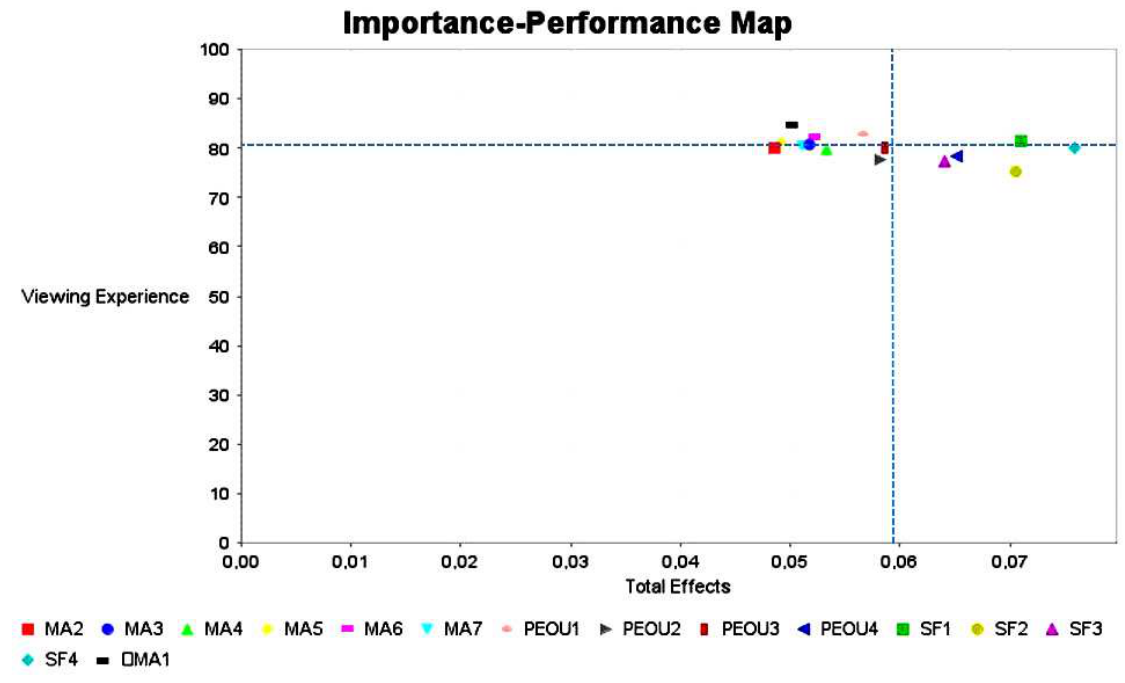
Figure 3. IPMA viewing